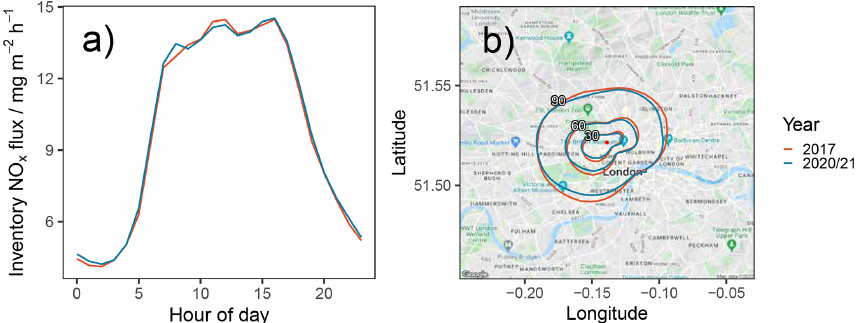
Figure A2. Comparison of (a) the diurnal profile of the inventory-generated time series and (b) the 30%, 60% and 90% footprint con- tribution contours for the 2017 data set in black and the 2020/2021 data set in red. Map in (b) produced from Google Maps (© Google Maps 2021), accessed using an API in R.